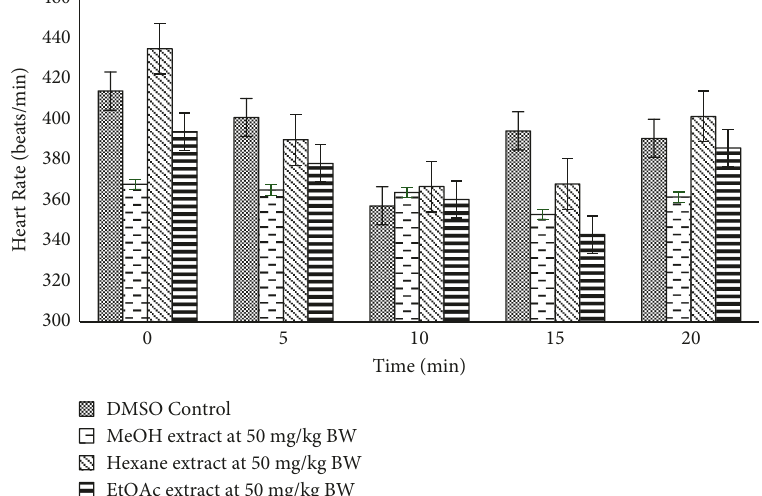
Figure 6: The effects of crude extracts from S. serotina on heart rate versus DMSO control when administered intravenously at 50mg/kg BW ( n �